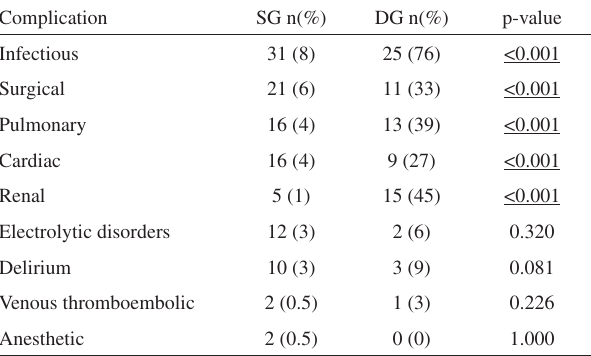
Table 7 – Complications of cohort patients, according to the outcomes